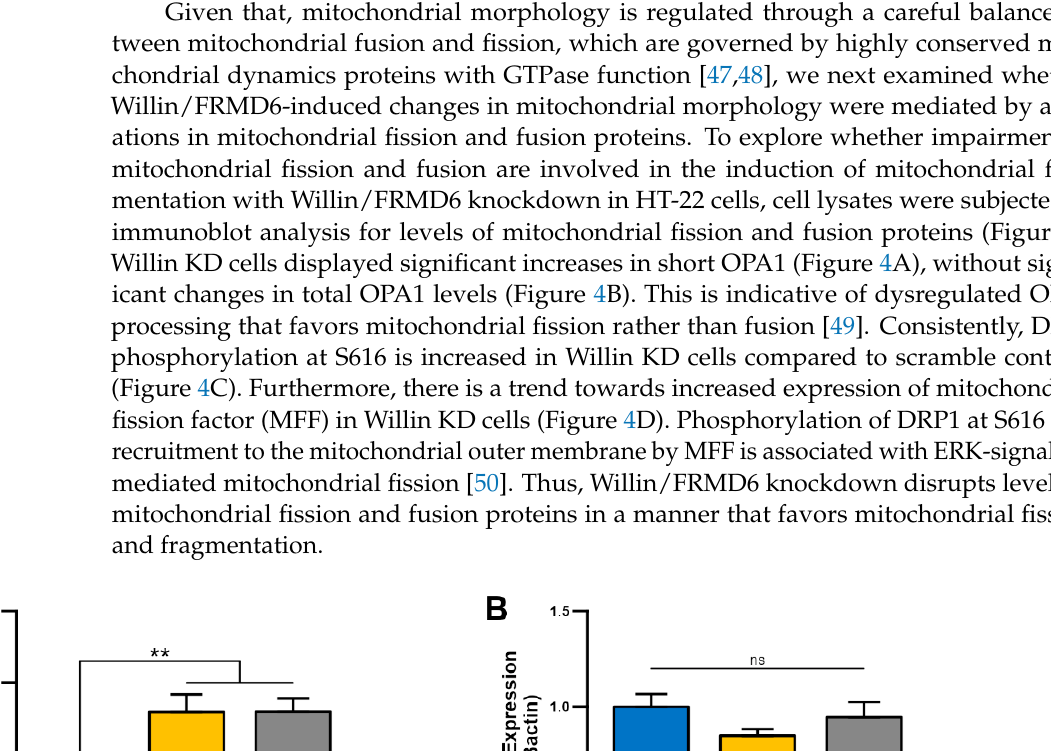
Figure 4 . Downregulation of Willin/FRMD6 alters levels of mitochondrial fission and fusion proteins. ( A , B ) Quantification of OPA1 (S5) ( A ) and total OPA1 ( B ) immunoreactive bands relative to β -actin in the indicated cell lysates. Short isoforms of OPA1 are associated with mitochondrial fission. Data are expressed as fold change relative to the scramble group. n = 3 per group. ** p <0.01. ns = no significant difference between all groups. ( C ) Quantification 12hosphorpho-DRP1-S616 immunoreactive bands normalized to total DRP1 in the indicated groups. Data are expressed as fold change relative to the scramble group. Representative immunoblots are shown underneath. n = 3 per group. * p < 0.05. ( D ) Quantification of MFF immunoreactive bands, normalized to β -actin in the indicated groups. Data are expressed as fold change relative to the scramble group. Representative immunoblots are shown underneath. n = 3 per group. # p < 0.1.